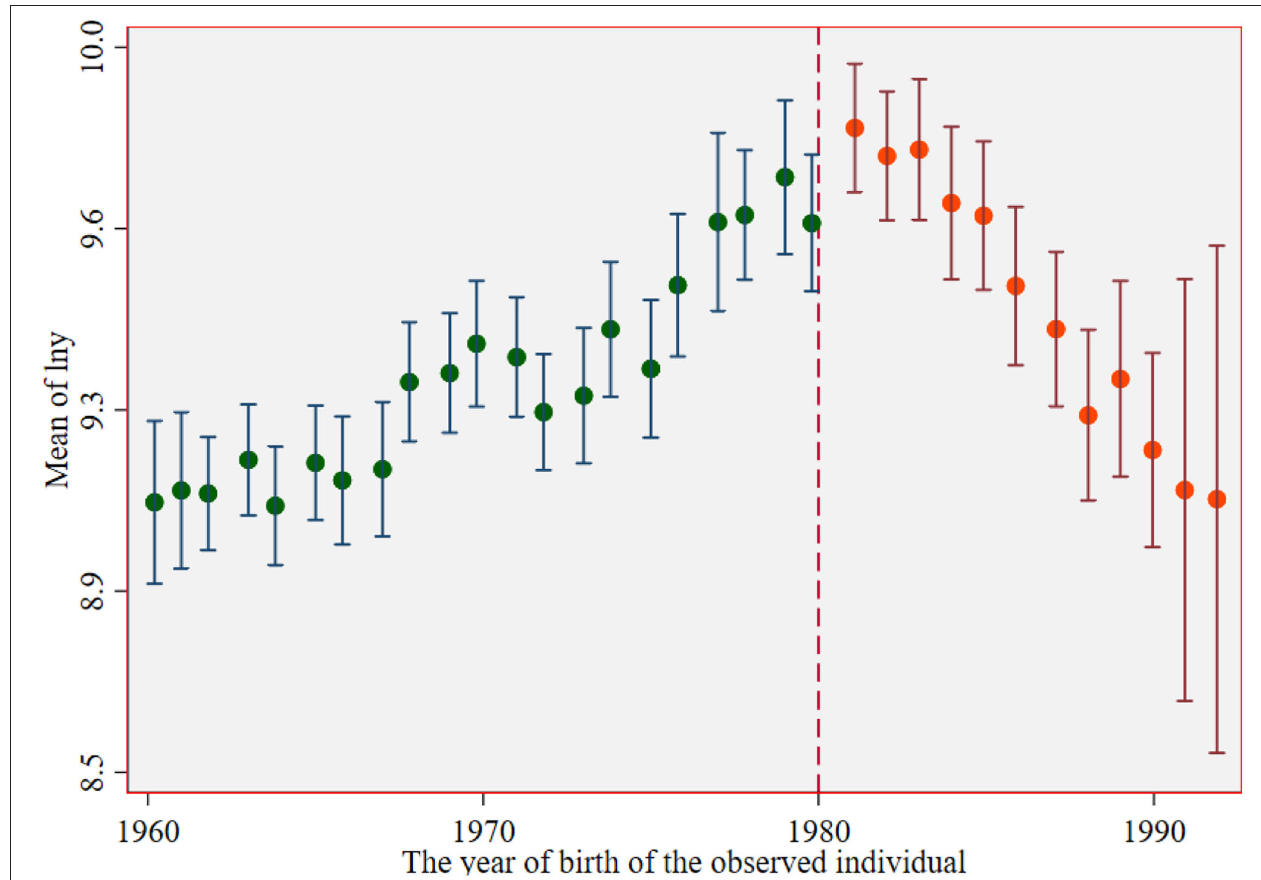
FIGURE 5 | The change of density distribution of observed individuals before and after the